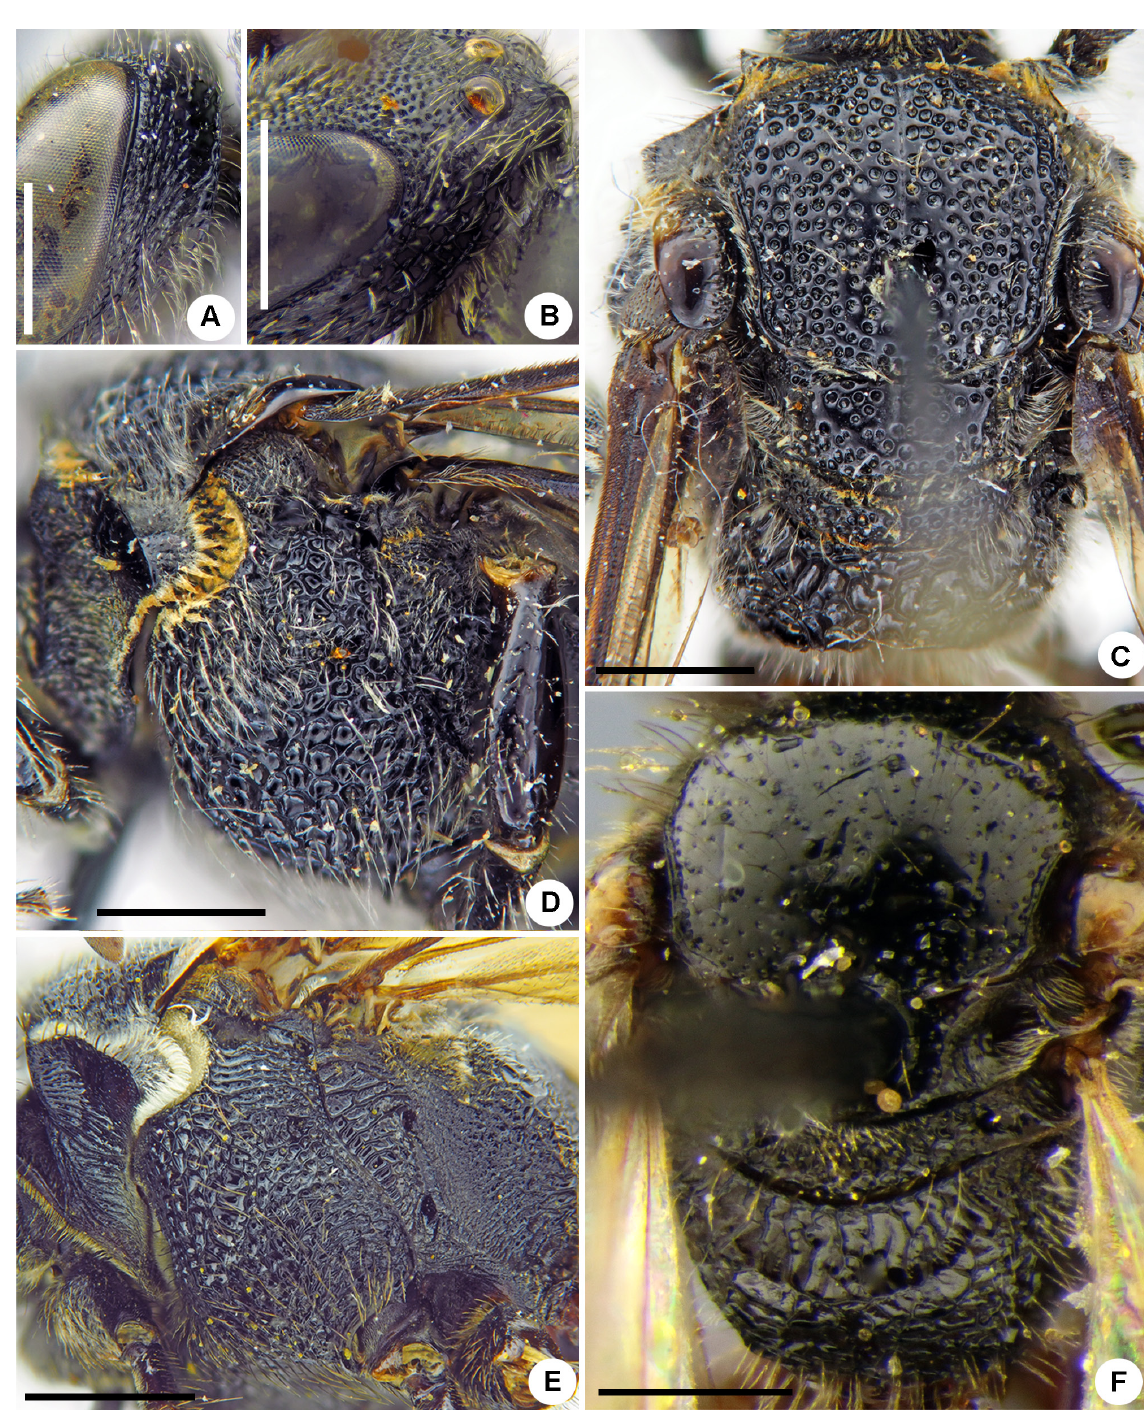
Fig. 4. Diagnostic characters of species of Sphecodes . A – B . Males. C – F . Females. A . Genal area and lateral preoccipital carina in lateral view. B . Vertex and longitudinal carina in dorso-lateral view. C – F . Mesosoma in dorsal (C, F) and lateral views (D–E). A – B . S. montanus Smith, 1879. C – D . S. fumipennis Smith, 1853. E . S. albilabris (Fabricius, 1793). F . S. hakkariensis Warncke, 1922. Scale bars = 1.0